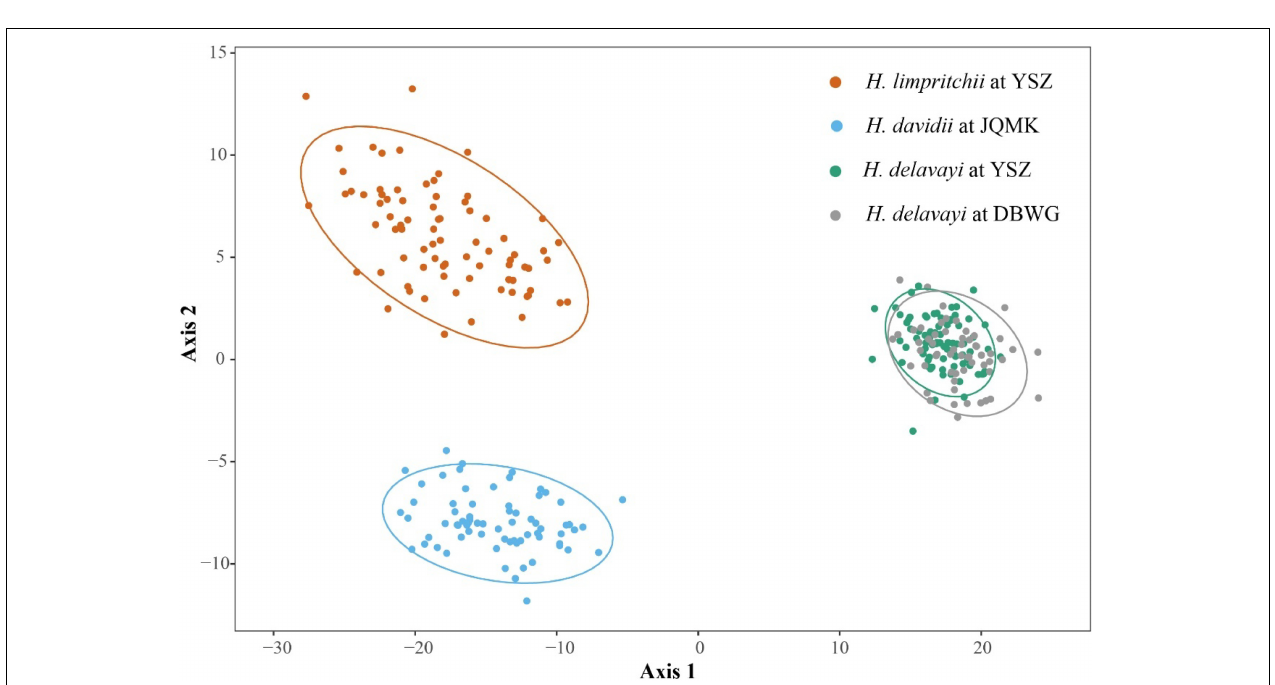
FIGURE 4 | Principal coordinate analysis (PCoA) based on the first two principal coordinate axes of ten floral traits of three Habenaria species with ellipse type assumed using a multivariate t-distribution with a 95% confidence level.